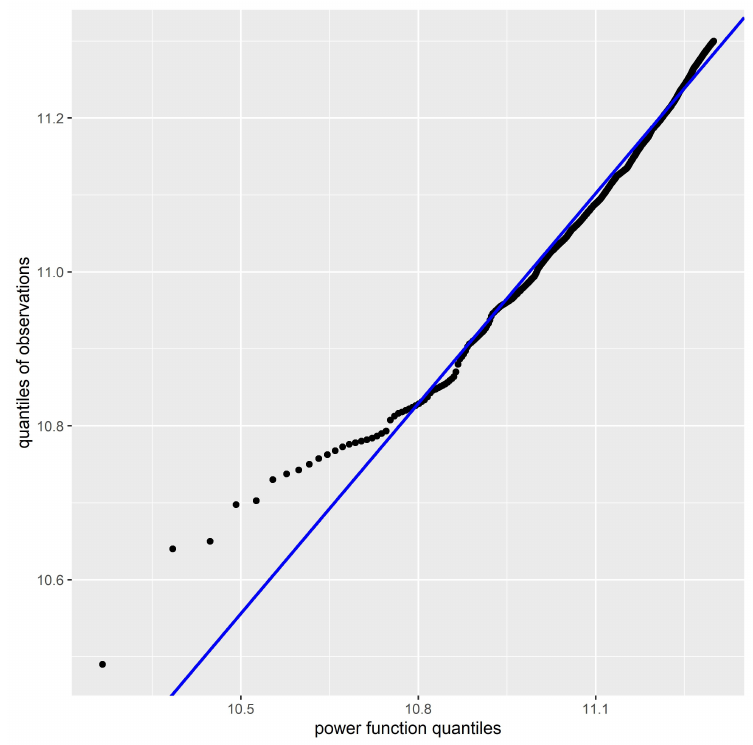
Figure 5. Power function Q–Q plot for the times of women’s 100 m faster than 11.3 s, where the five smallest times were omitted when calculating the regression